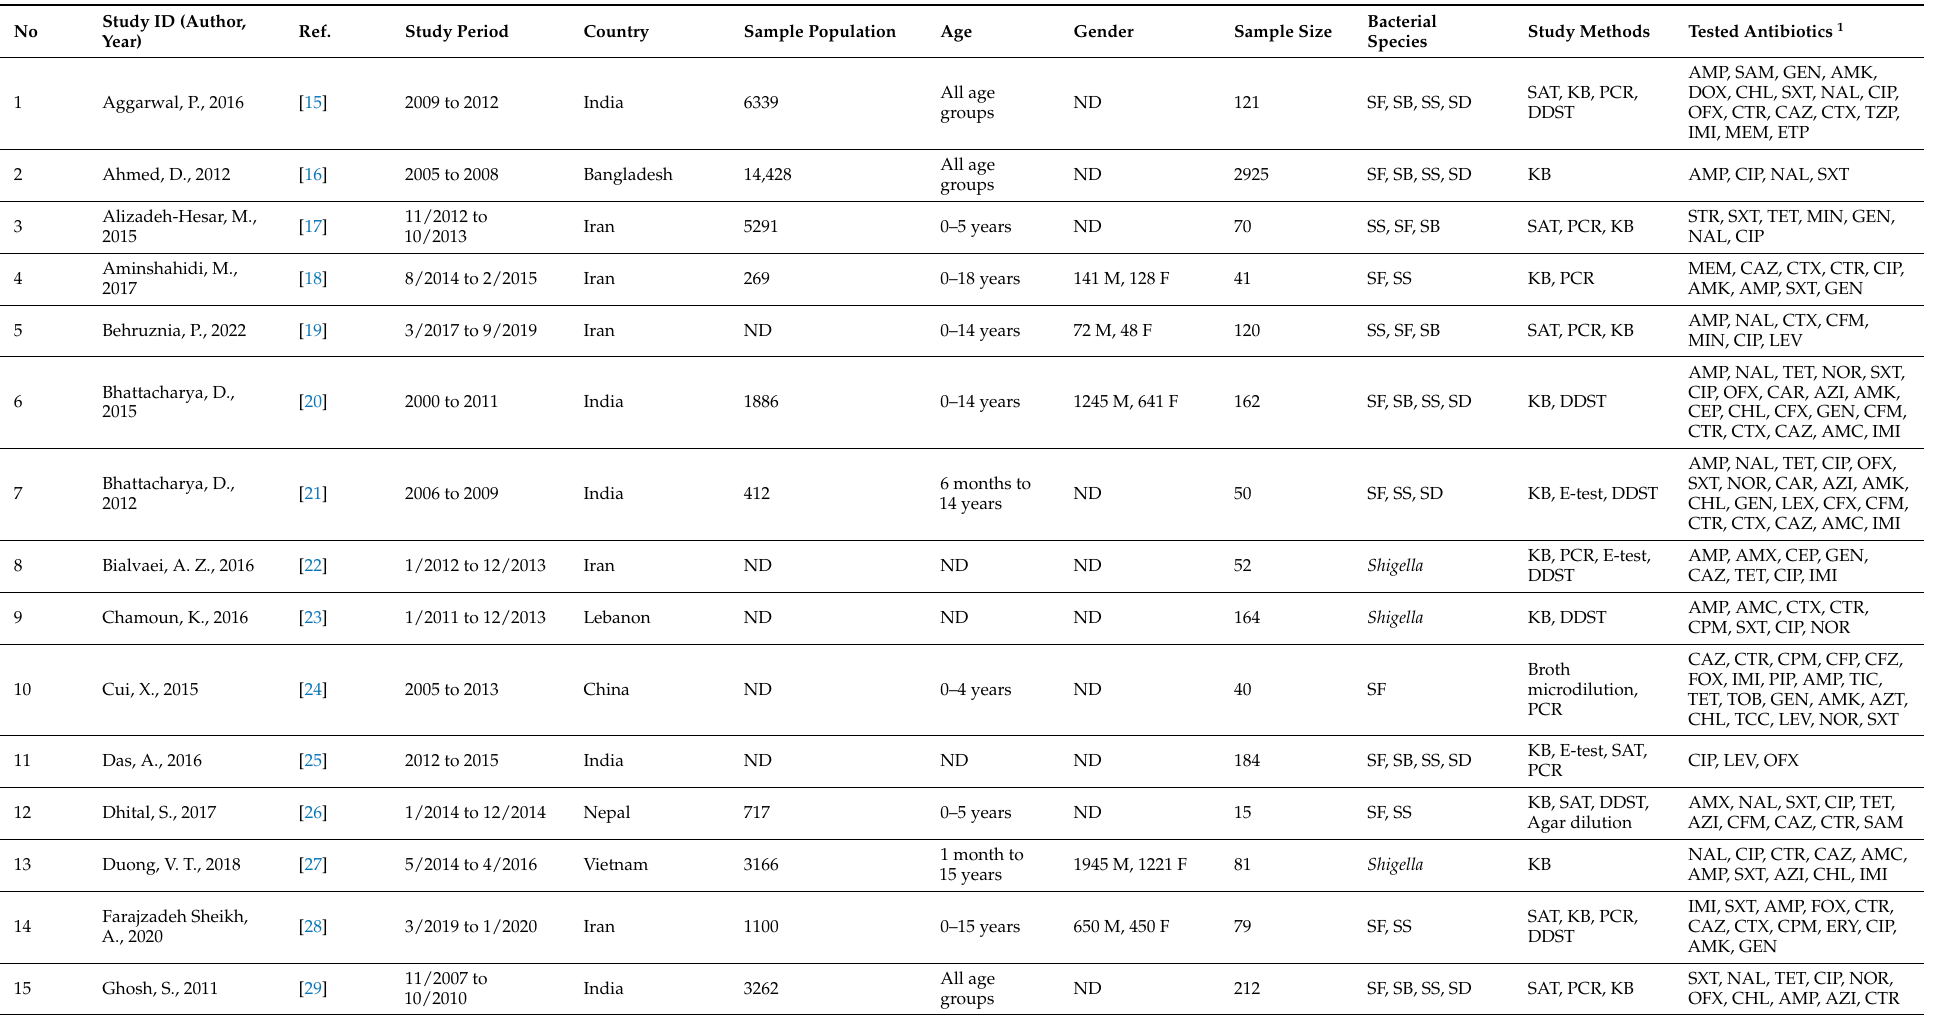
Table 1. Major characteristics of the 63 studies included in this systematic review and meta-analysis